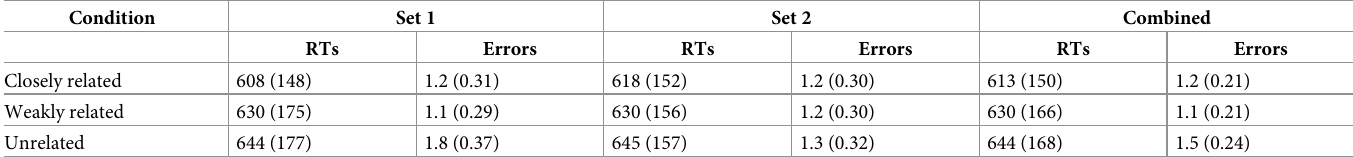
Table 5. Mean reaction times in milliseconds with standard deviations (in parentheses) and error rates for the priming conditions in each set and both sets com- bined in Experiment 2. Condition Set 1 Set 2 Combined RTs Errors RTs Errors RTs Errors Closely